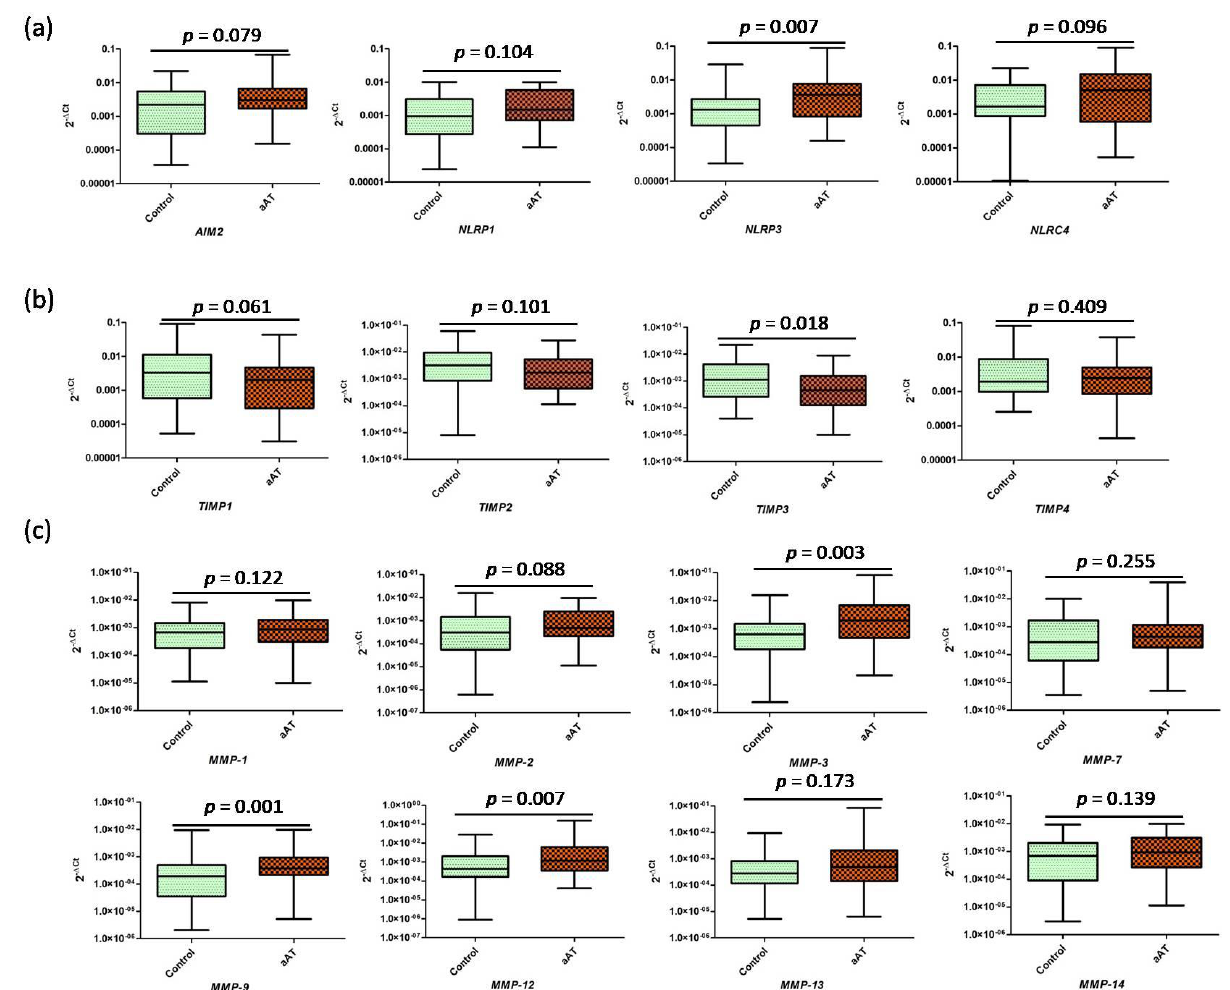
Figure 6. Transcript expression of ( a ) inflammsomes, ( b ) the tissue inhibitors of metalloproteinases (TIMPs), and ( c ) matrix metalloproteinases (MMPs) in the cultured macrophages after challenging with IL − 33 − primed neutrophils/NETs in the aAT patient and controls groups.